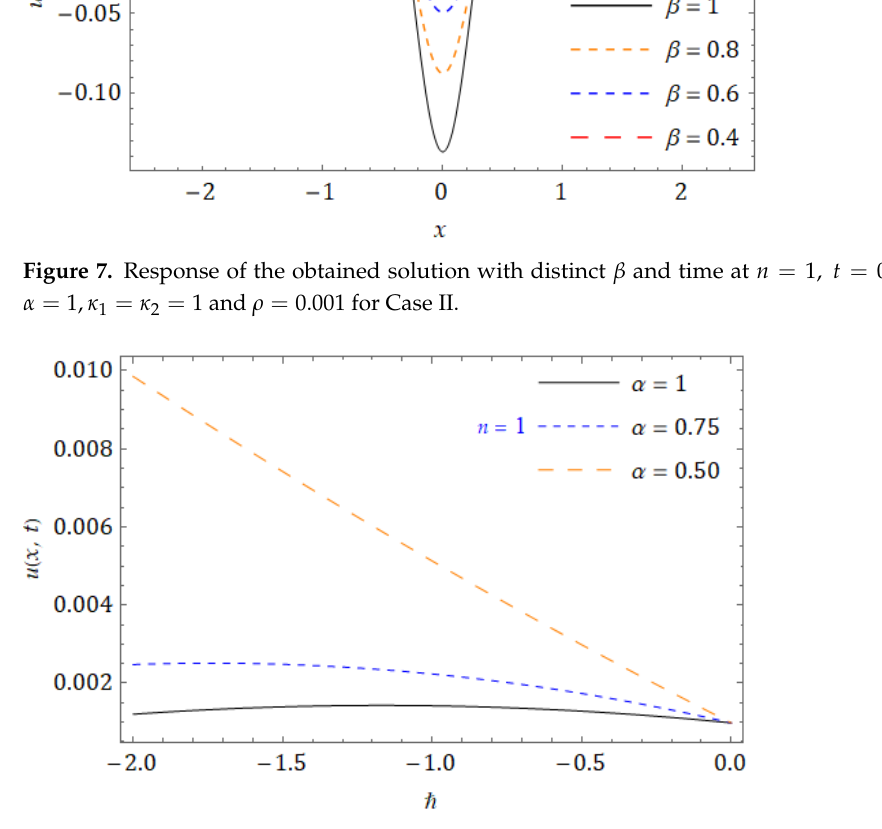
= κ = 1, n = 1 and ρ = 2 1